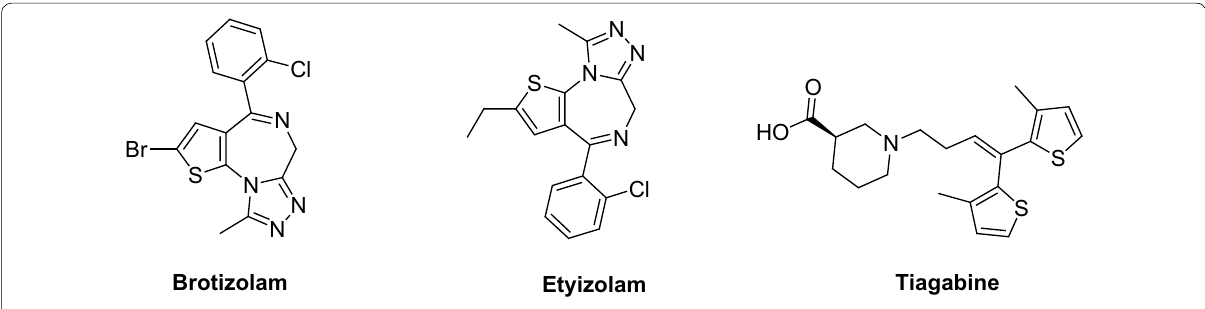
Fig. 1 Structures of some bioactive compounds containing thiophene